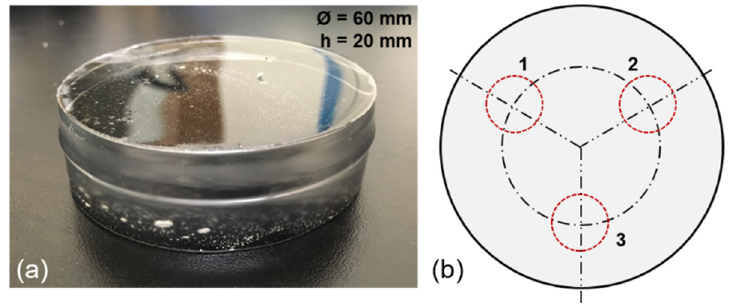
Figure 2. ( a ) Cylindrical test specimen used for firmness and hardness tests; ( b ) Probing locations and probing sequence.